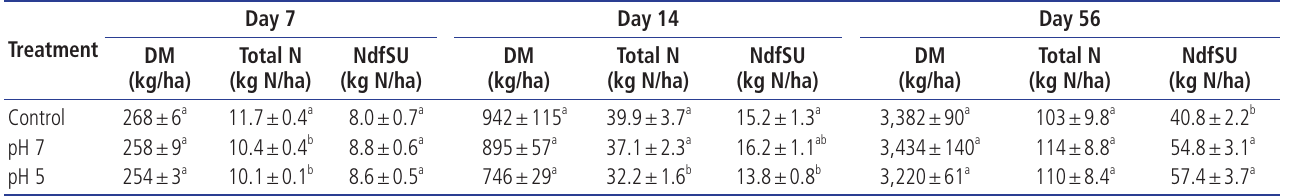
Table 3. Total nitrogen content and the amount of N derived from slurry urea (NdfSU) in herbage as affected by the pH of pig slurry during regrowth of perennial ryegrass sward